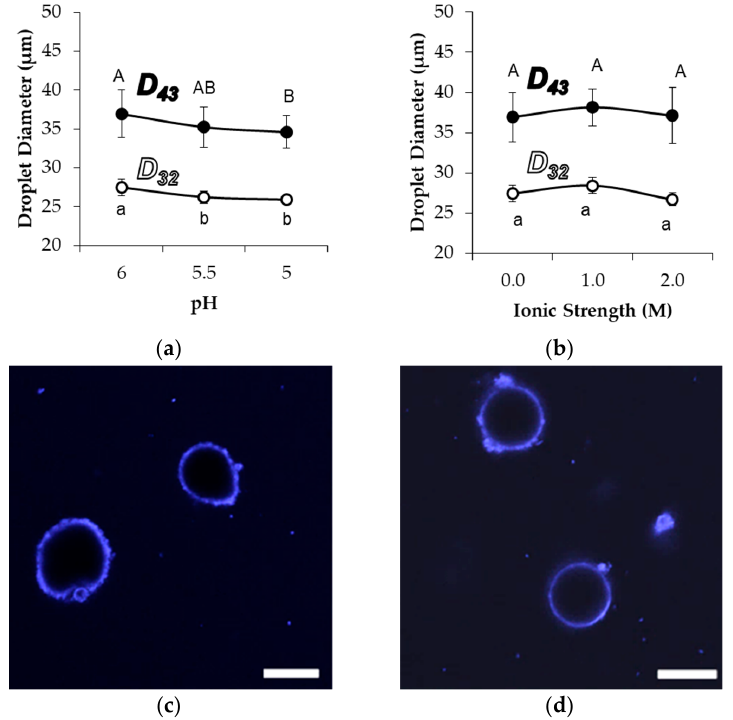
Figure 4. Droplet size and morphology of MG 58 emulsions during the first day of storage as influenced by acidification and increased sodium chloride concentration, showing moment-based average droplet diameters with exposure to ( a ) decreasing pH or ( b ) increasing ionic strength, as well as confocal micrographs of droplets after adjustment of the solution to ( c ) pH 5.0, 0 M ionic strength or ( d ) pH 6.0, 2.0 M ionic strength. Uppercase/lowercase letters in ( a , b ) denote groups of D 43 /D 32 data that were significantly different as a function of pH or ionic strength; scale bars = 20 μ m. The addition of either 0.1% Tween 20 (non-ionic surfactant) or 0.1% SDS (anionic surfactant) significantly decreased the average diameters of MG 58 emulsion droplets (Figure 5). As with pH adjustment, the droplet size distribution indicated a general shift in the droplet size, as opposed to the formation of a separate population of smaller droplets (not shown). CLSM images showed that the addition of 0.1% Tween 20 to either MG 58 emulsions or MG X emulsions caused the droplets to